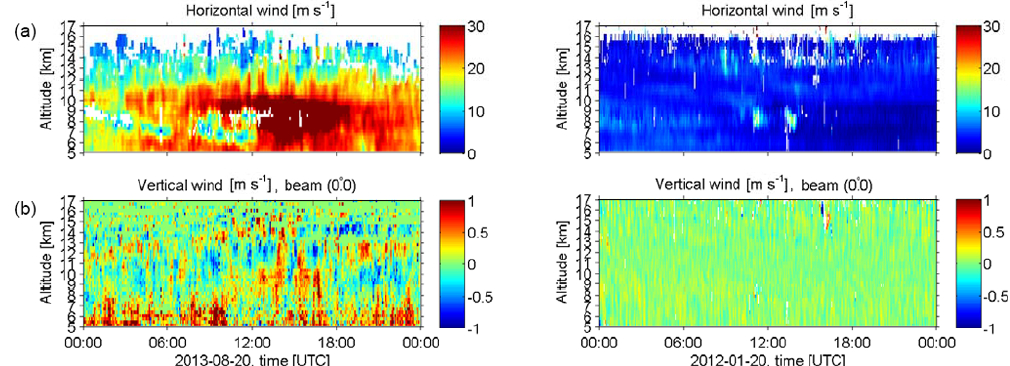
Figure 1. Height–time intensity of wind measurements with MAARSY running a tropospheric experiment on 20 August 2013 (left panels) and 20 January 2012 (right panels). Upper panels are horizontal winds and lower panels are vertical winds.